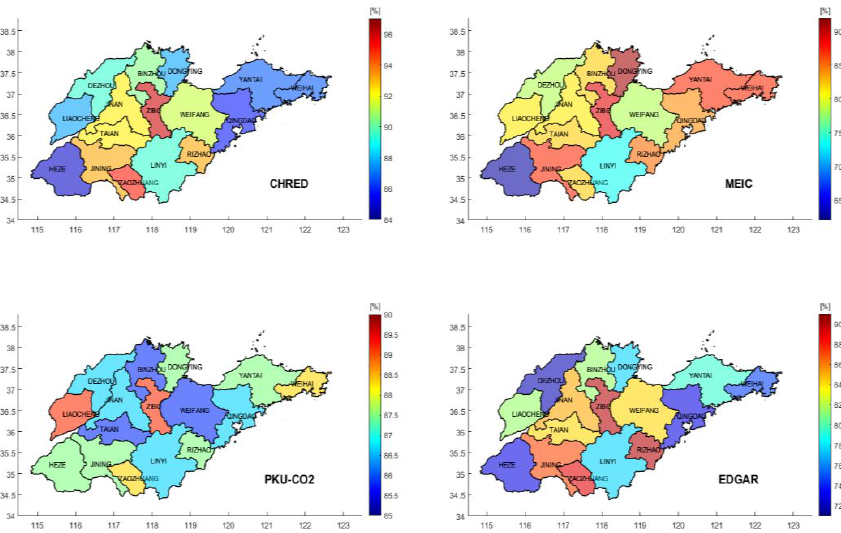
Figure 3. The ratios of industrial CO 2 emissions (industrial energy use and industrial processes) to the aggregated city-level emissions in 2010 from CHRED, MEIC, EDGAR, and PKU-CO 2 .